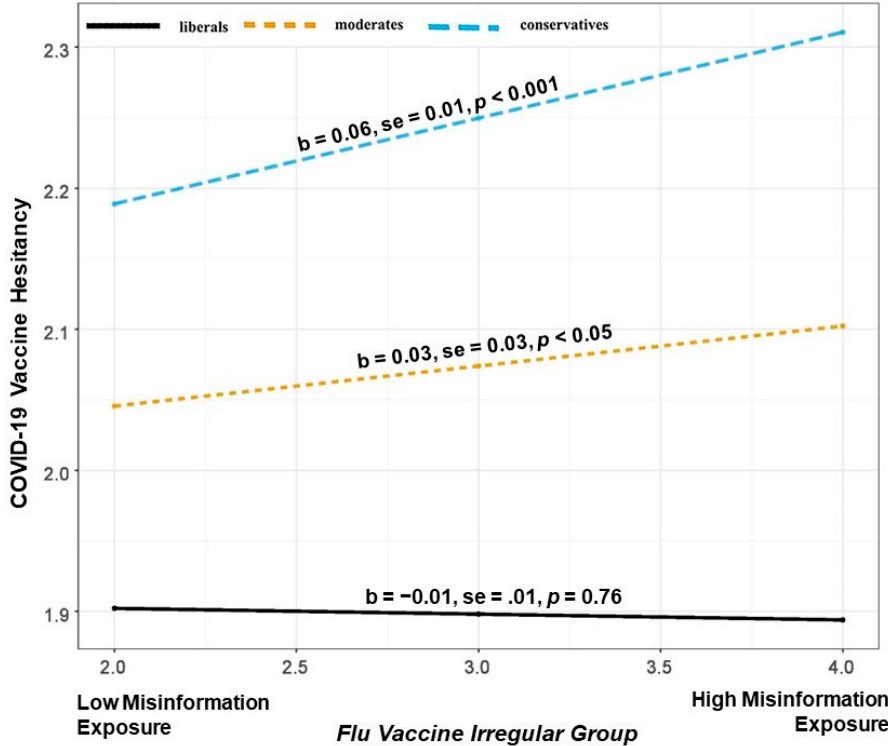
Figure 3. Illustration of the interaction between perceived misinformation exposure and political ideology in predicting COVID-19 vaccine hesitancy for the flu vaccine irregular group.